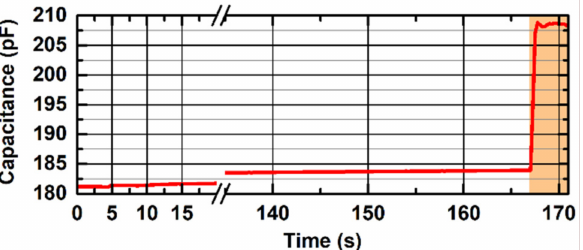
Figure 7. The result of the capacitance stability measurement over ambient relative humidity variation for the probe V2 with a hydrogel layer applied to the sensor surface. During the first 160 s, the ambient relative humidity is increased from <10% to 100% with no contact applied to the sensor surface, resulting in only 2.8 pF variation. After reaching 100% ambient relative humidity, contact with the backhand of a healthy volunteer is applied to the capacitive sensing sensor (orange-shaded area) to demonstrate the device functionality in extreme measurement conditions. The x -axis is interrupted between 35 s and 135 s for visualization purposes.